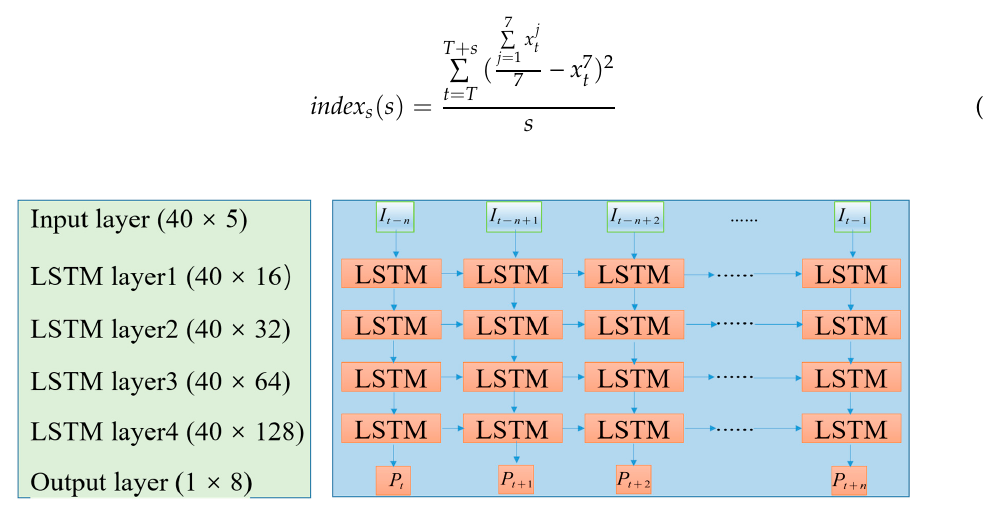
Figure 8. The detailed parameters of each layer of MLSTM. Sensors 2020 , 20 , 823